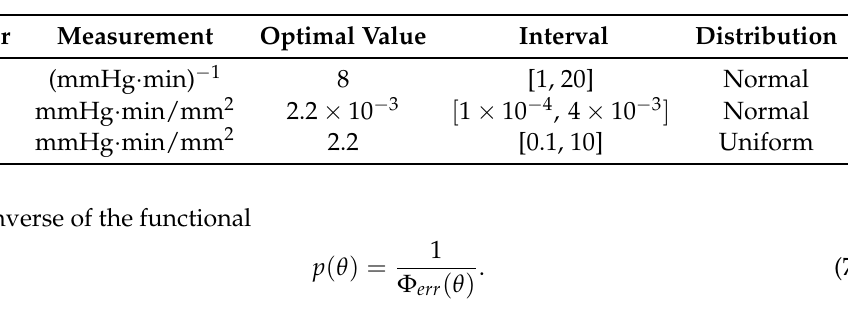
Table 2. Estimated model parameters: notation, units, best-fit value giving a minimium of the functional Φ err ( θ ) (6) and plausible intervals of parameter values.